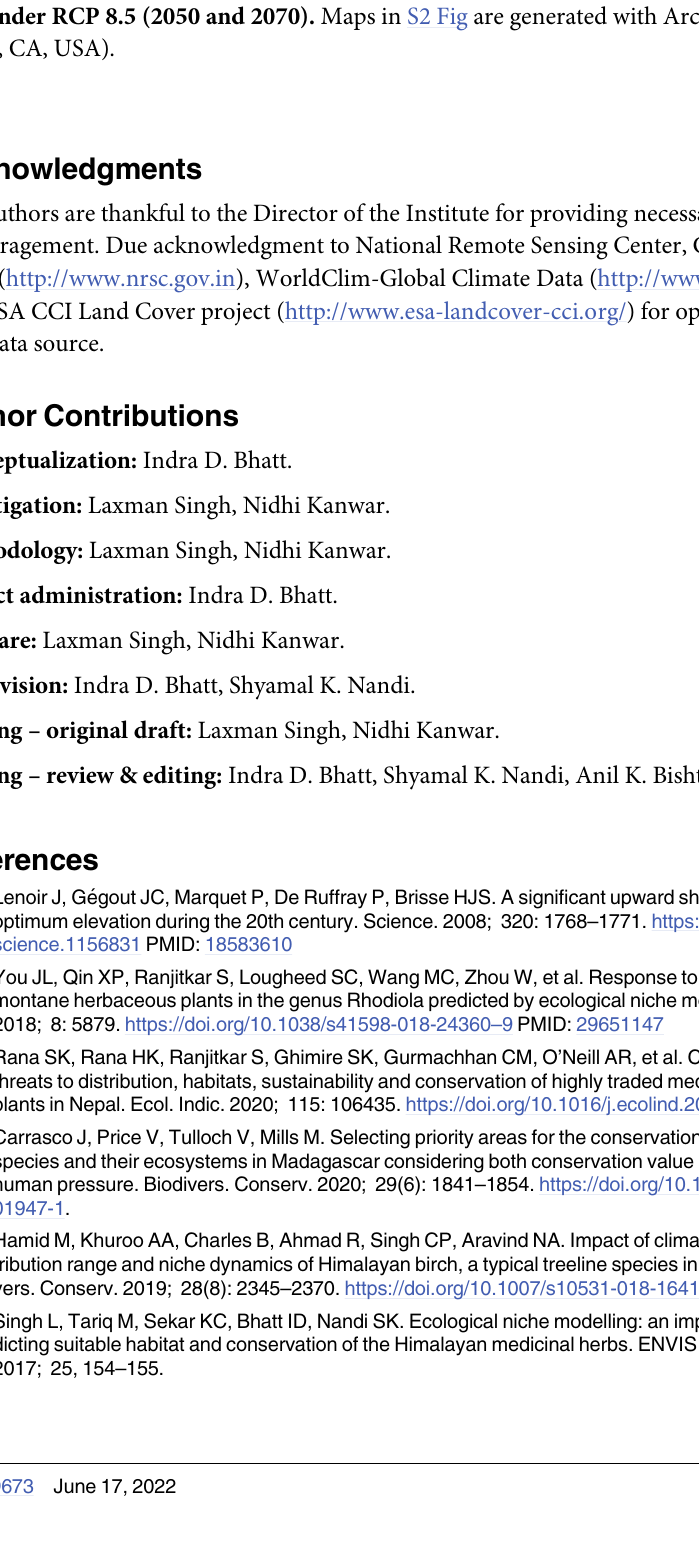
S1 Fig. Habitat transformations with respect to present distribution into different classes as depicted under RCP 4.5 (2050 and 2070). Maps in S1 Fig are generated with ArcGIS ver- sion 10.3 (ESRI, CA, USA). (TIF) S2 Fig. A comparative studies on habitat transformations between present distribution and under RCP 8.5 (2050 and 2070). Maps in S2 Fig are generated with ArcGIS version 10.3 (ESRI, CA, USA).